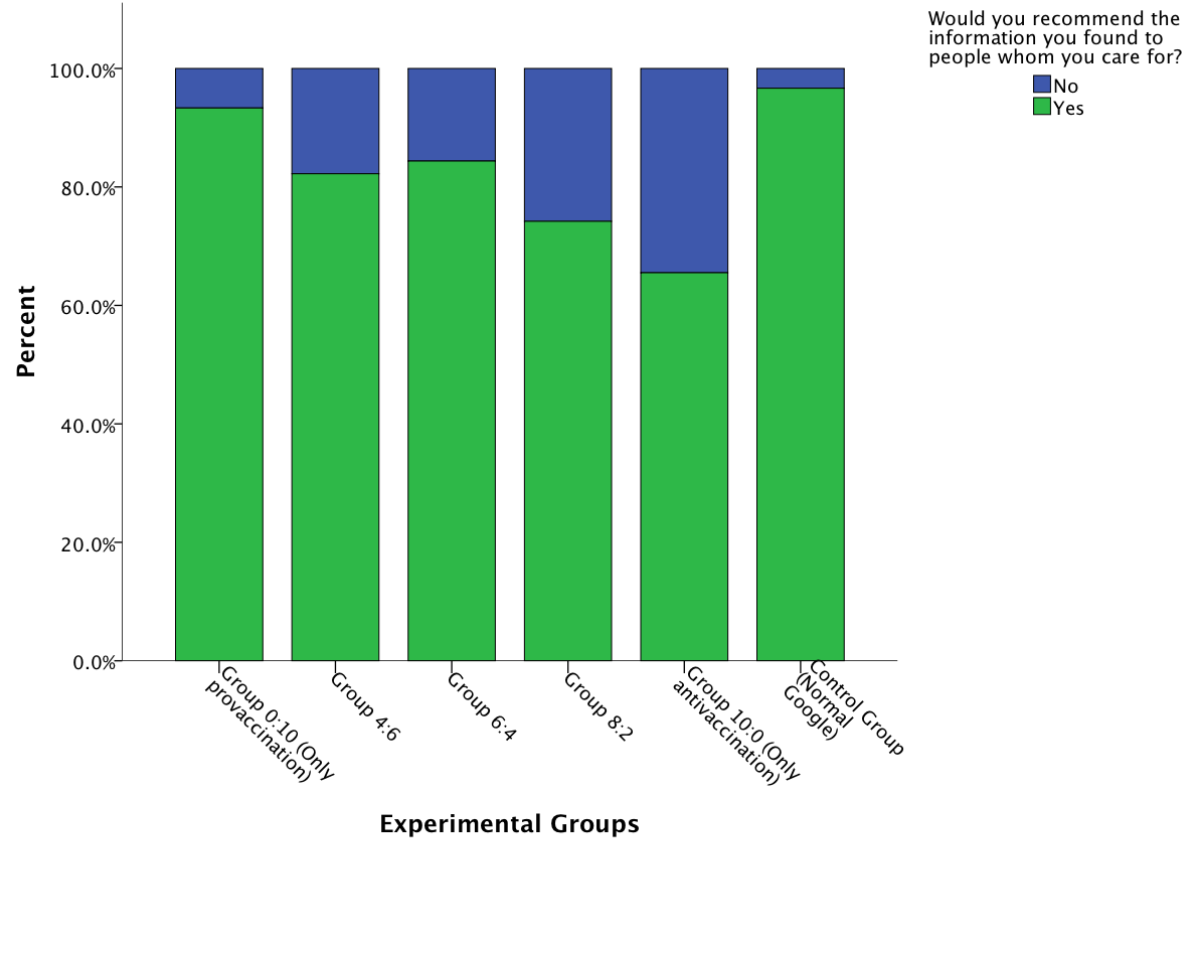
Figure 6. Bar graph of general assessment of information retrieved by experimental